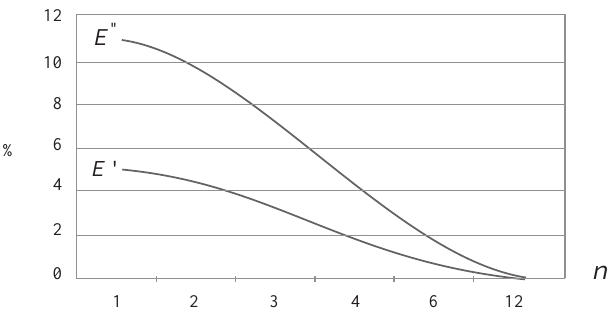
Fig. 4. Summary functions of contractor’s costs ( E ' ) and owner’s revenue ( E " )